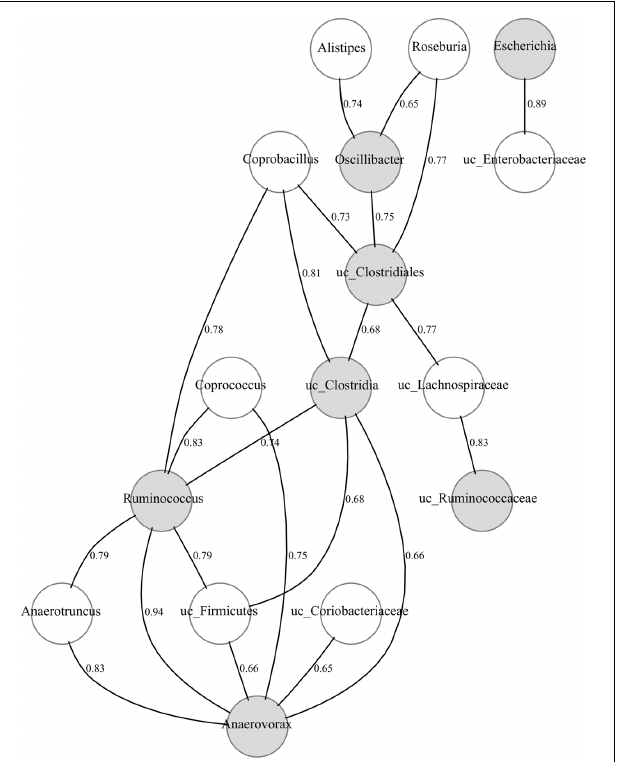
FIGURE 4 | Bayesian network of microbial composition in CD − samples of patients (A–E), during treatment, and the candidate protective taxa. The significant positive correlations ( p -value < 0.01) between the candidate protective taxa and other members of the bacterial community are shown. The correlation coefficients are indicated. Gray and white nodes represent candidate and correlated taxa, respectively. Candidate taxa with no-correlations are not